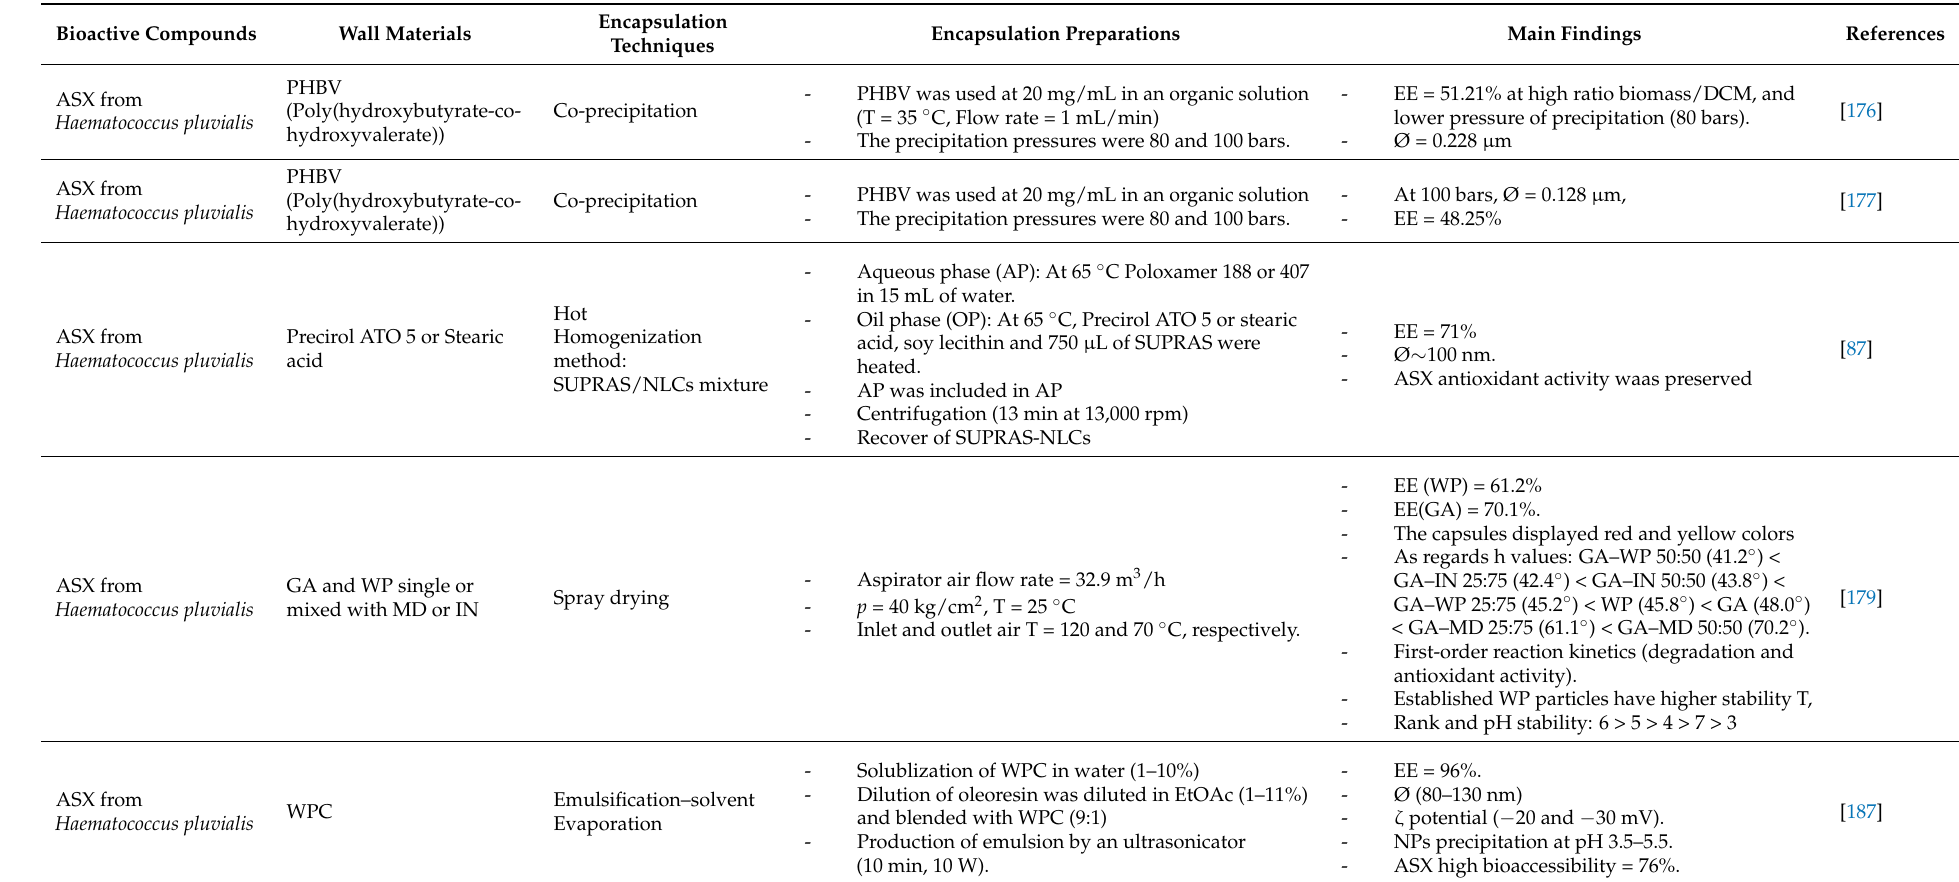
Table 3. Main examples of encapsulated microalgal astaxanthin and